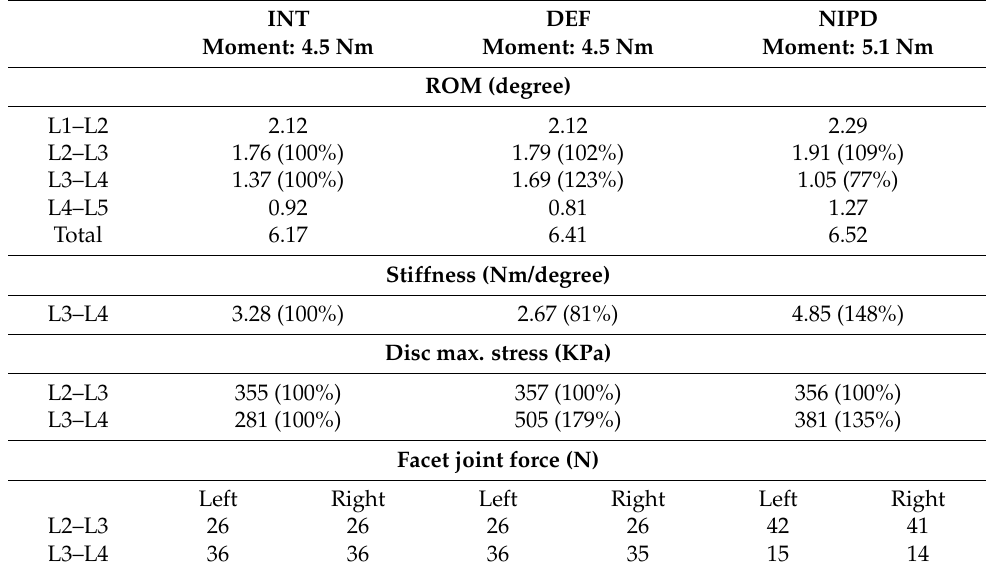
Table 3. Comparison of the biomechanical characteristics among the three FE models during extension.